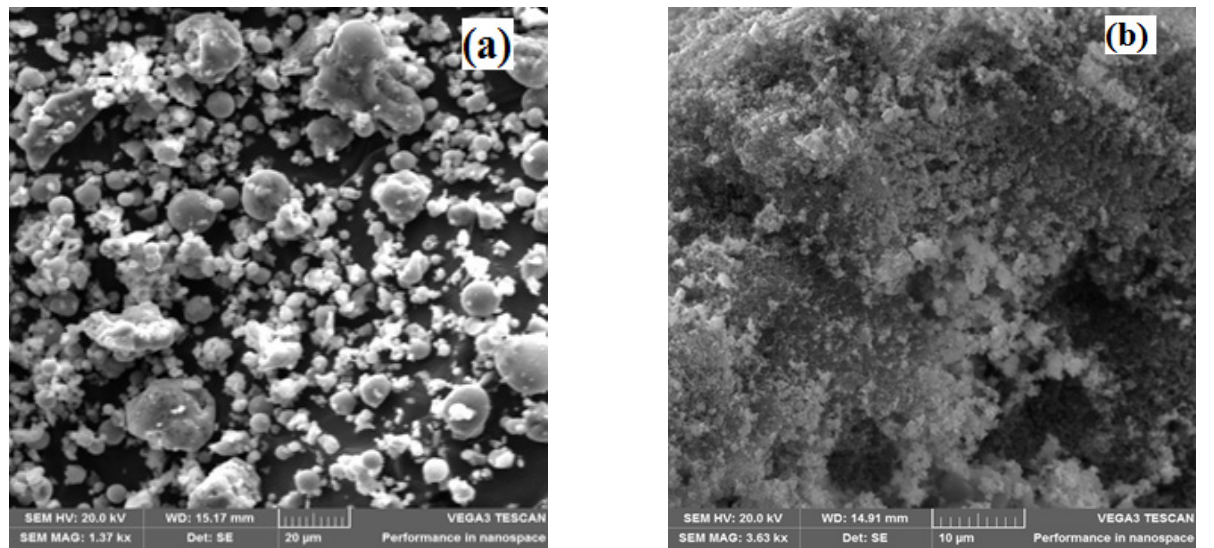
Figure 4. ( a ) SEM image of SAFA, ( b ) SEM image of SNPs.